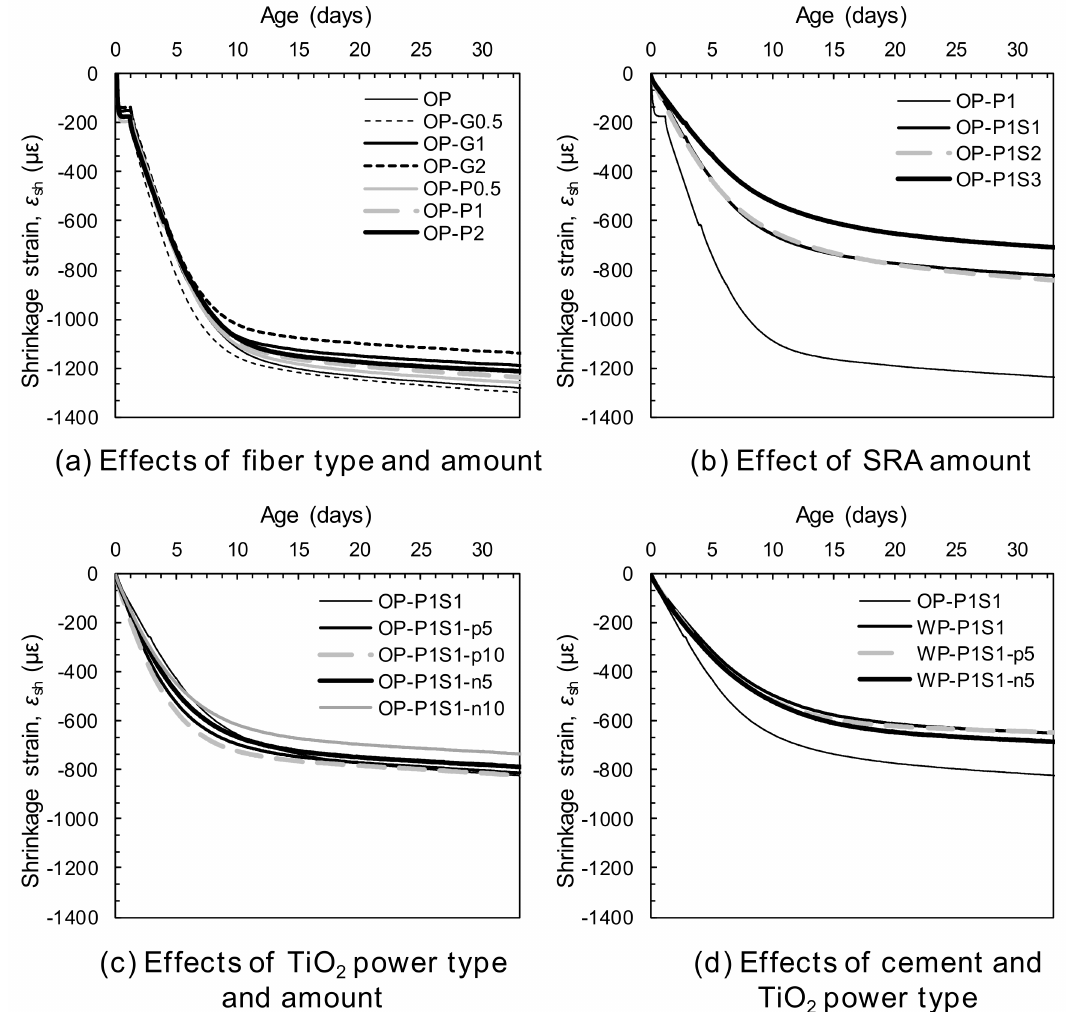
Figure 10. Shrinkage behaviors: ( a ) the e ff ects of the fiber type and amount, ( b ) the e ff ect of the SRA amount, ( c ) the e ff ects of the TiO 2 powder type and amount, and ( d ) the e ff ects of the cement and the TiO 2 powder